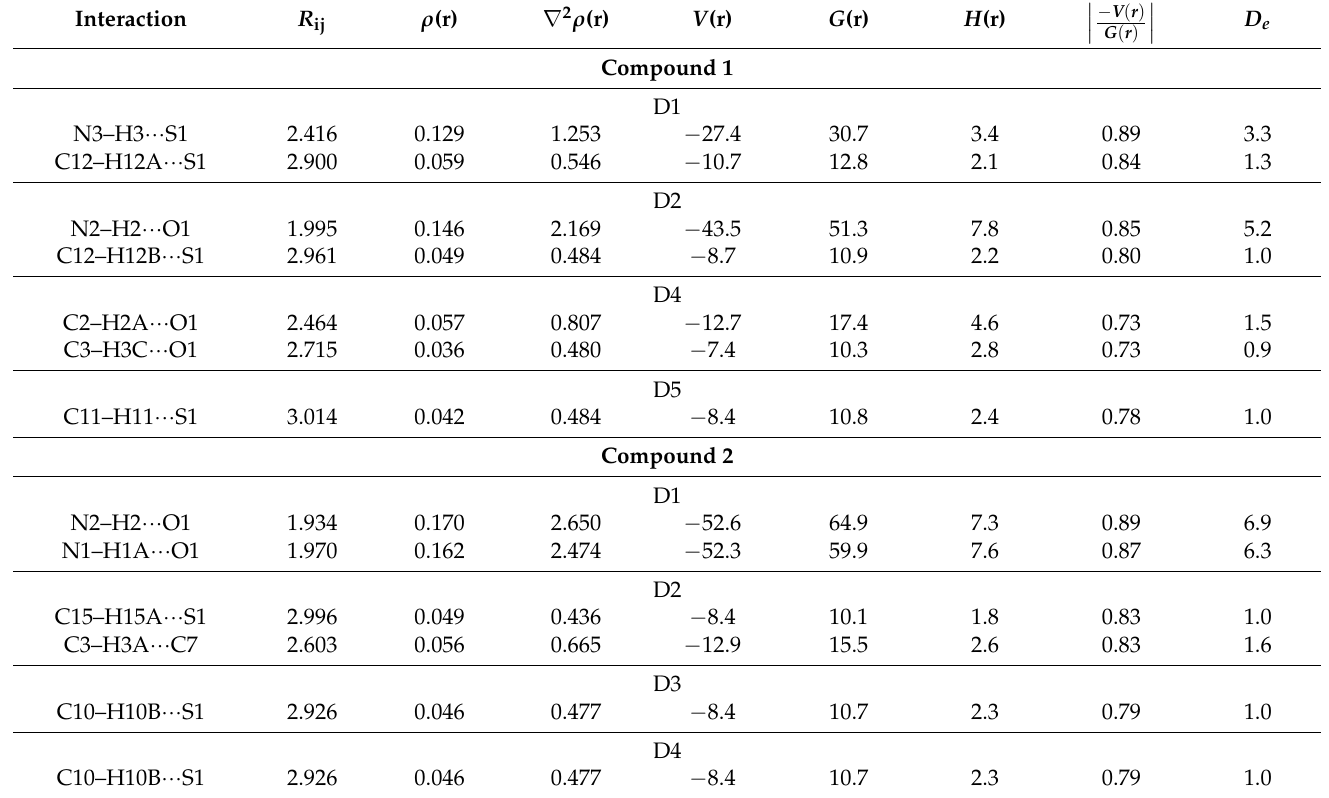
Table 5. Topological parameters for selected intermolecular interactions in different dimers of compounds 1 and 2 at their (3, − 1) BCPs. Definitions: R ij , bond path (Å); ρ (r), electron density